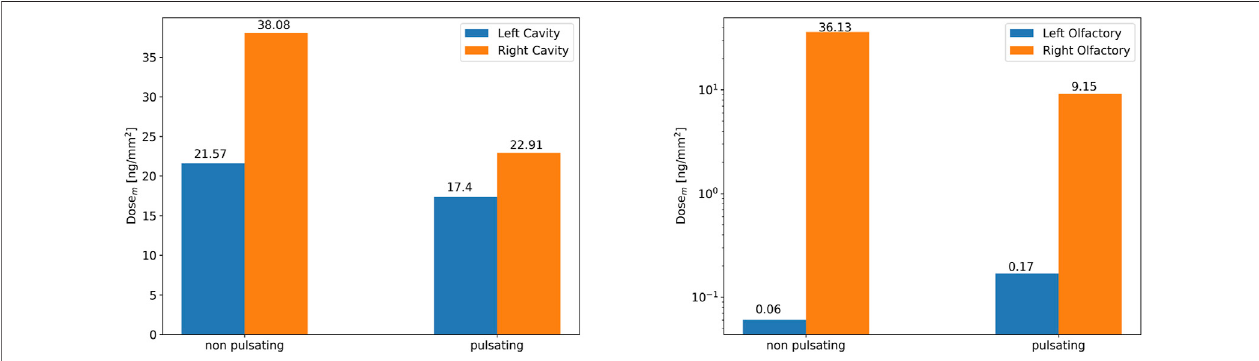
FIGURE13| Comparisonofaveragedoseperareaintherightandleftnasalcavity (leftpanel) andtheolfactoryregions (rightpanel) fornon-pulsatileandpulsatile aerosol delivery with average air fl ow rate of 4 L/min. The dose is presented as mass per area at t (cid:2) 1.98 s (end of inhalation). The surface areas of the right (left) nasal cavities and olfactory regions are 21,393.1 mm 2 (21,249.80 mm 2 ) and 330 mm 2 (337 mm 2 ),